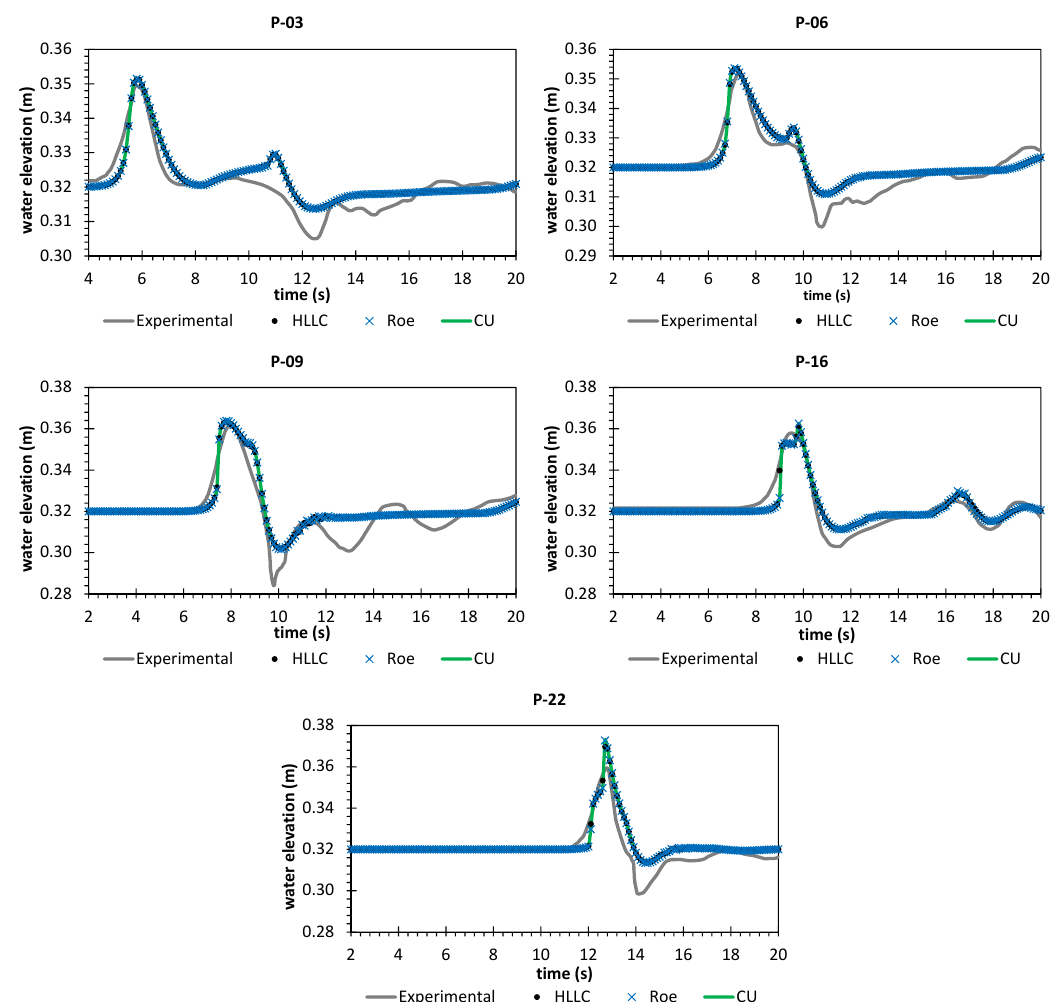
Figure 13. Case 3: comparison between observation and numerical